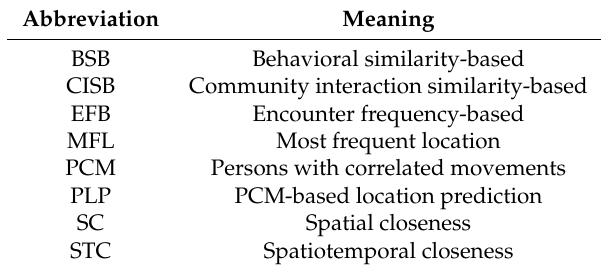
Table 6. List of